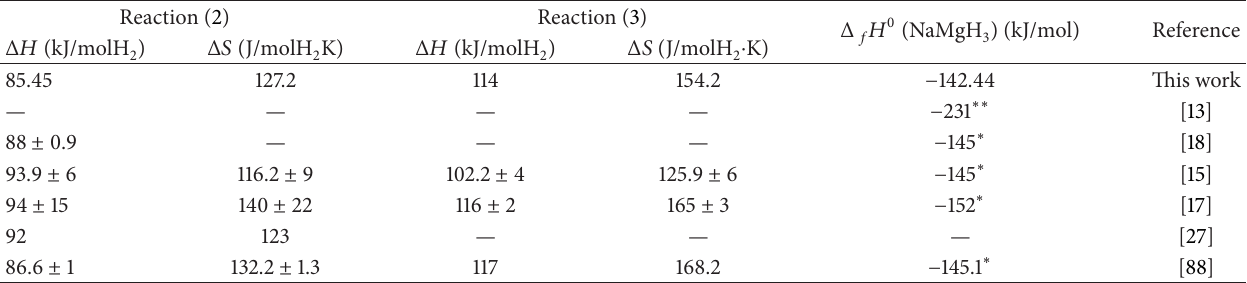
decomposition from PCI and DSC experiments. 3